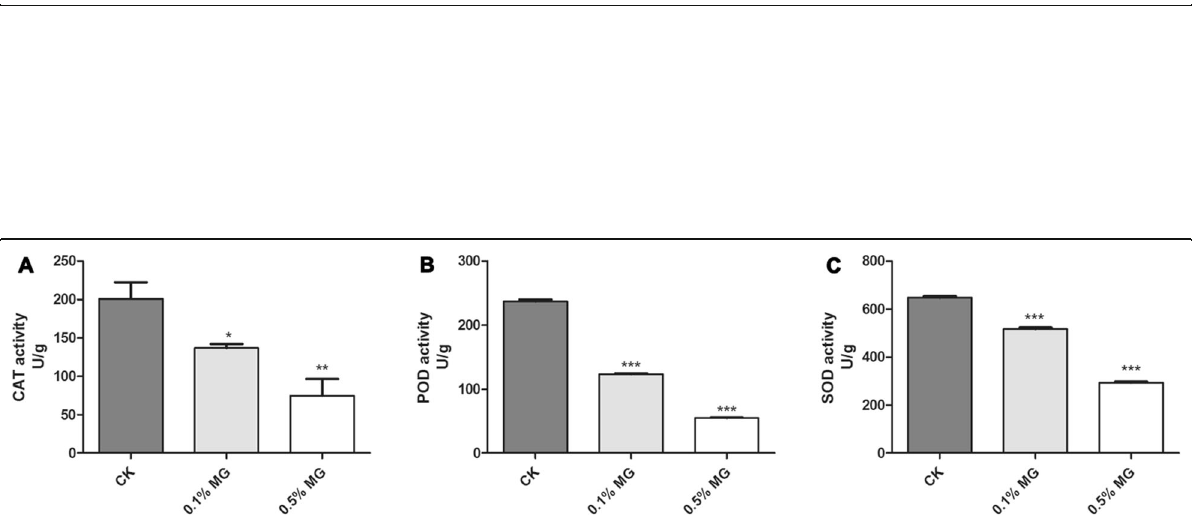
Fig. 5 Effects of MG the antioxidant enzymes activities of CAT ( A ) and SOD ( B ) and POD ( C ) in F. graminearum . * p < 0.05, ** p < 0.01, *** p < 0.001. Catalase (CAT), superoxide dismutase (SOD), and peroxidase